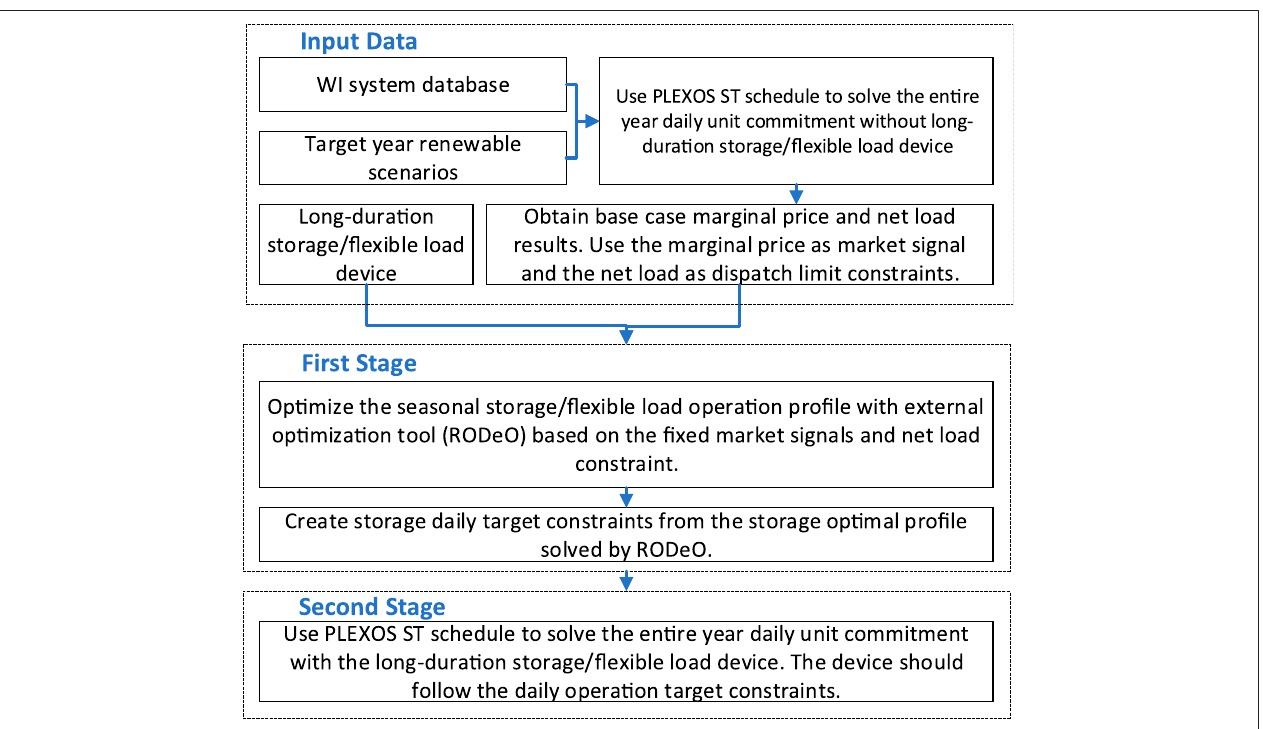
FIGURE 6 | Simpli fi ed fl owchart of the two-stage price-taker model.